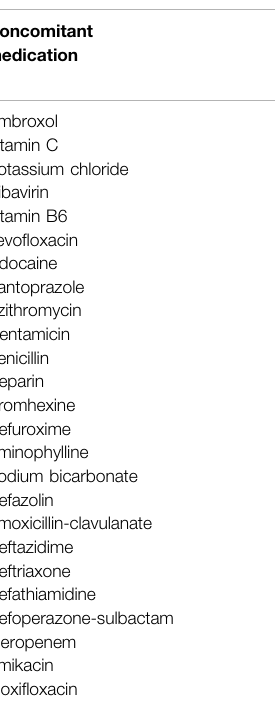
TABLE 3 | Univariate analyses results. Concomitant